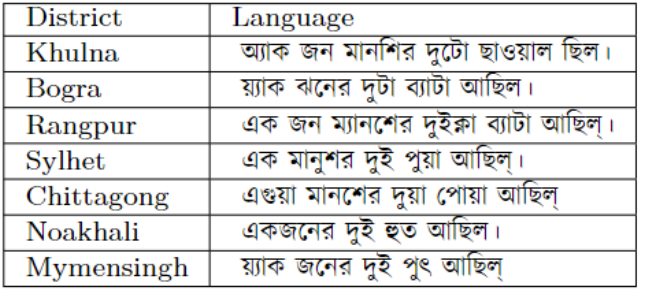
Figure 1. Representation of a sample English sentence ‘A man has two sons’ in the seven regional Bangla language used in this